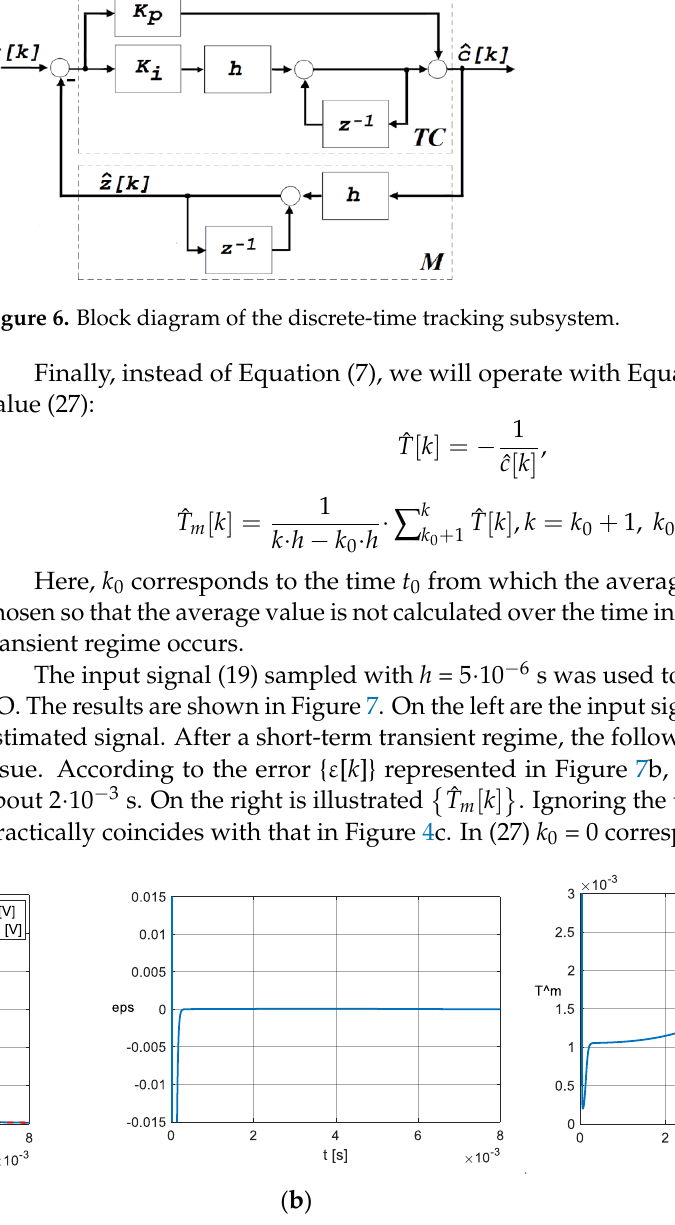
Figure 7. The estimation of the parameter {𝑇̂ 𝑚 [𝑘]} 𝑘∈𝑁 in the case that the signal (19) is sampled: ( a ) the input signal; ( b ) the signal { [ 𝑘 ]}; ( c ) the estimated average value T^m . Additionally, for the validation of the discrete-time PO, we used the input signal (28) with a time constant which for t = 4·10 − 3 s has a jump from the value T 1 = 5.8·10 − 3 s to the value T 2 = 2.9·10 − 3 s.